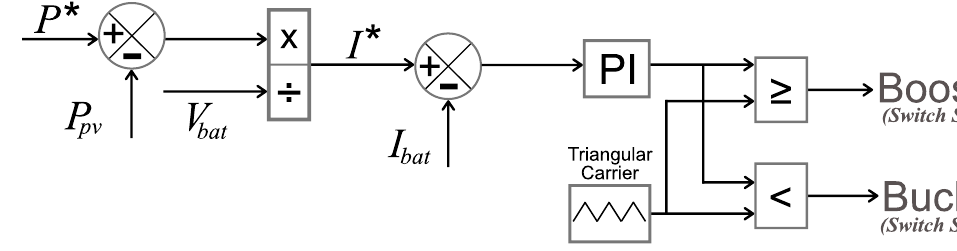
Figure 8. Proposed control strategy block